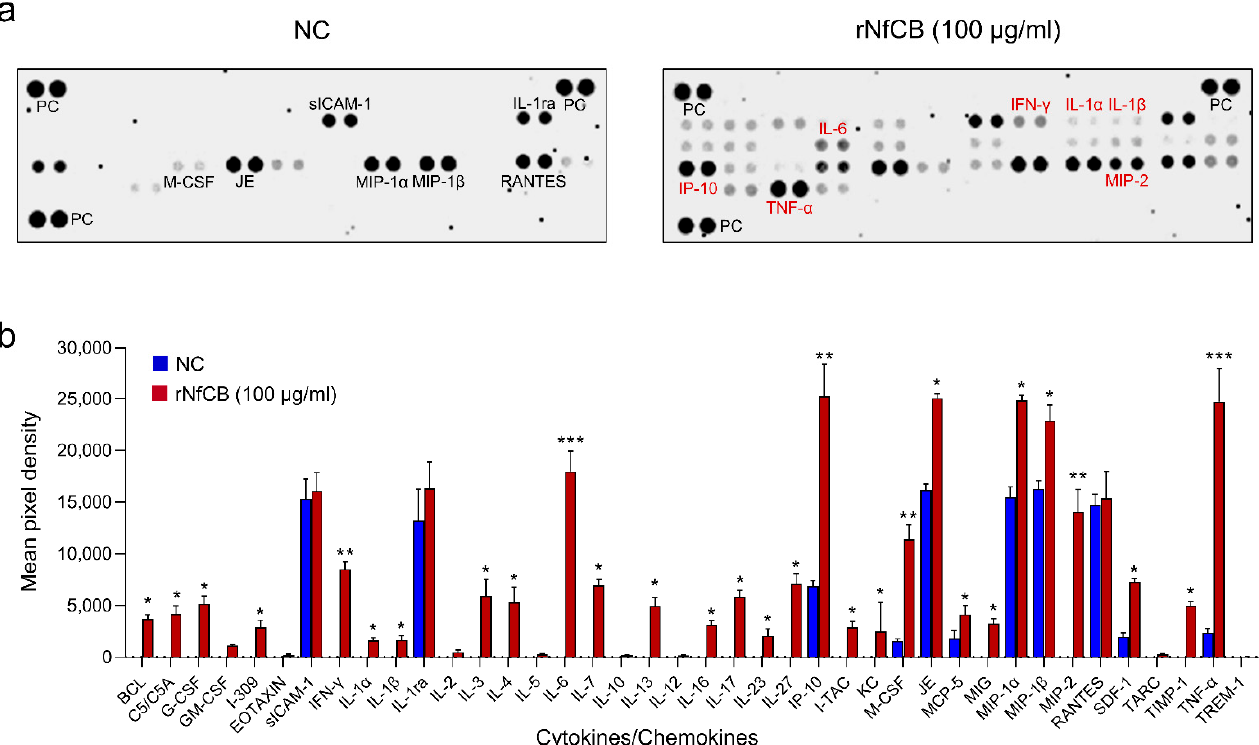
Figure 2. rNfCB induces the production of diverse cytokines/chemokines in BV-2 microglial cells. ( a ) Cytokine array assay. BV-2 microglial cells were stimulated with rNfCB (100 µg/mL). The culture supernatants were harvested and subjected to cytokine array analysis. The culture supernatant from rNfCB-untreated BV-2 microglial cells was used as a negative control (NC). Each cytokine or chemokine is represented as double dots. PC is a positive reference control to verify the reaction. ( b ) Quantitative analysis. The density of dots corresponding to each cytokine or chemokine was analyzed quantitatively, and the value was presented as mean ± SD. One-way ANOVA with Dunnett’s post hoc test was performed as multiple comparisons. *** p < 0.0001, ** p < 0.001, * p < 0.01.